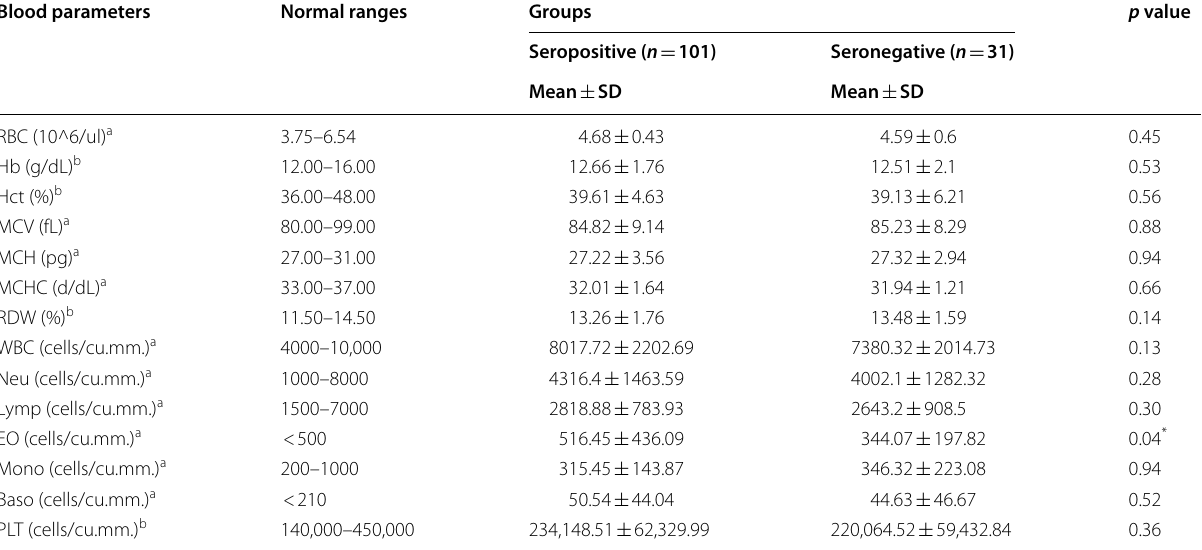
Table 4 Comparison of hematological parameters between Toxocara canis IgG seropositive and Toxocara canis IgG seronegative groups